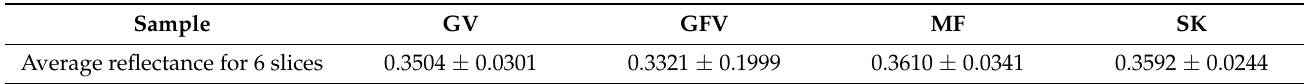
Table 4. Average reflectance for individual slices of all tested